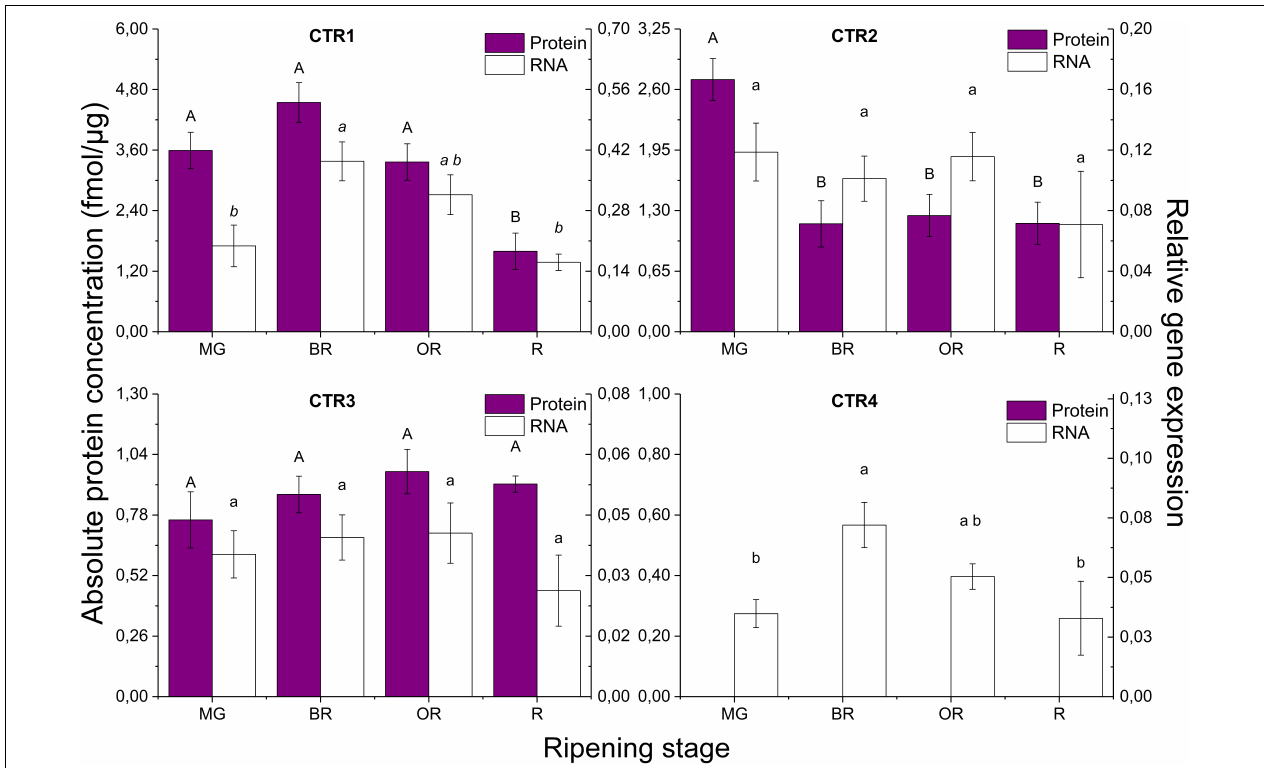
FIGURE 4 | Absolute protein quantification (fmol of target protein/ µ g of total membrane proteins) and relative gene expression of CTR1–CTR4 during tomato fruit ripening. MG, mature green; BR, breaker; OR, orange; R, red tomatoes. Error bars represent the standard error of the mean based on six biological replicates. Difference uppercase letters indicate significant differences between the absolute protein concentration levels of the four tomato ripening stages determined by Tukey’s HSD test ( p < 0.05). Different lowercase letters indicate significant differences between the relative gene expression levels of the four tomato ripening stages determined by Tukey’s HSD test ( p <